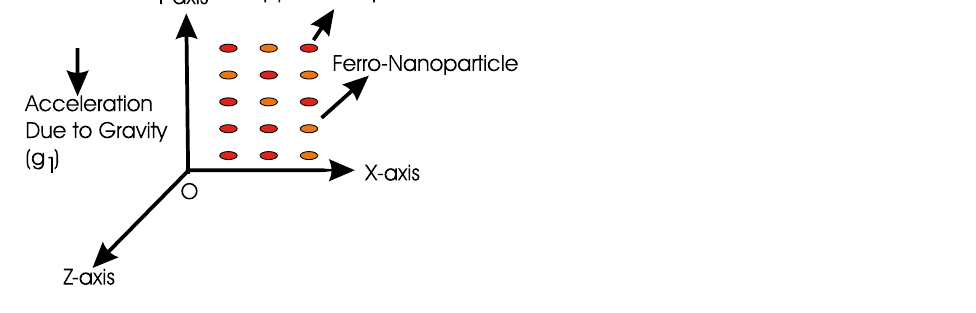
Figure 1. Schematic diagram of the